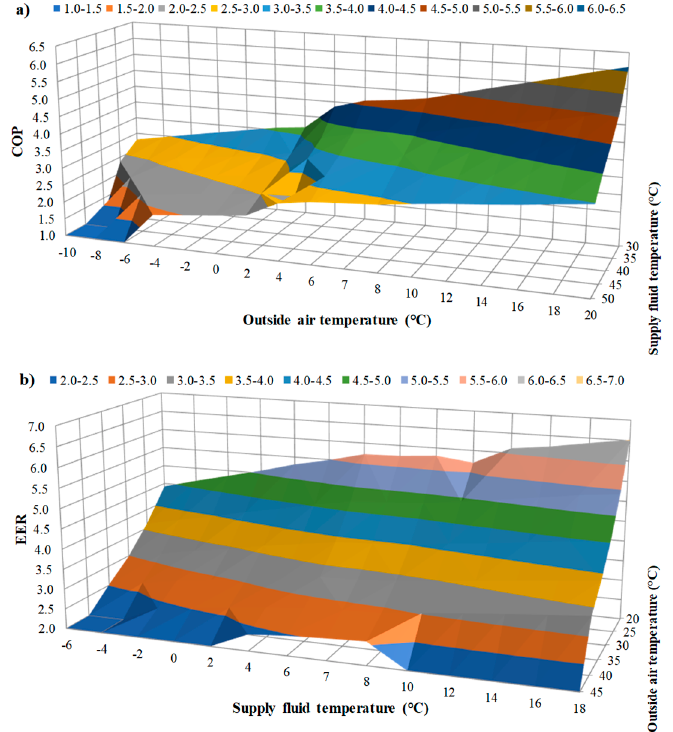
Figure 3. ( a ) Coefficient of performance (COP) of the heap pump and ( b ) energy efficiency ratio (EER) of the refrigerating system as a function of both outside air temperature and supply fluid temperature.